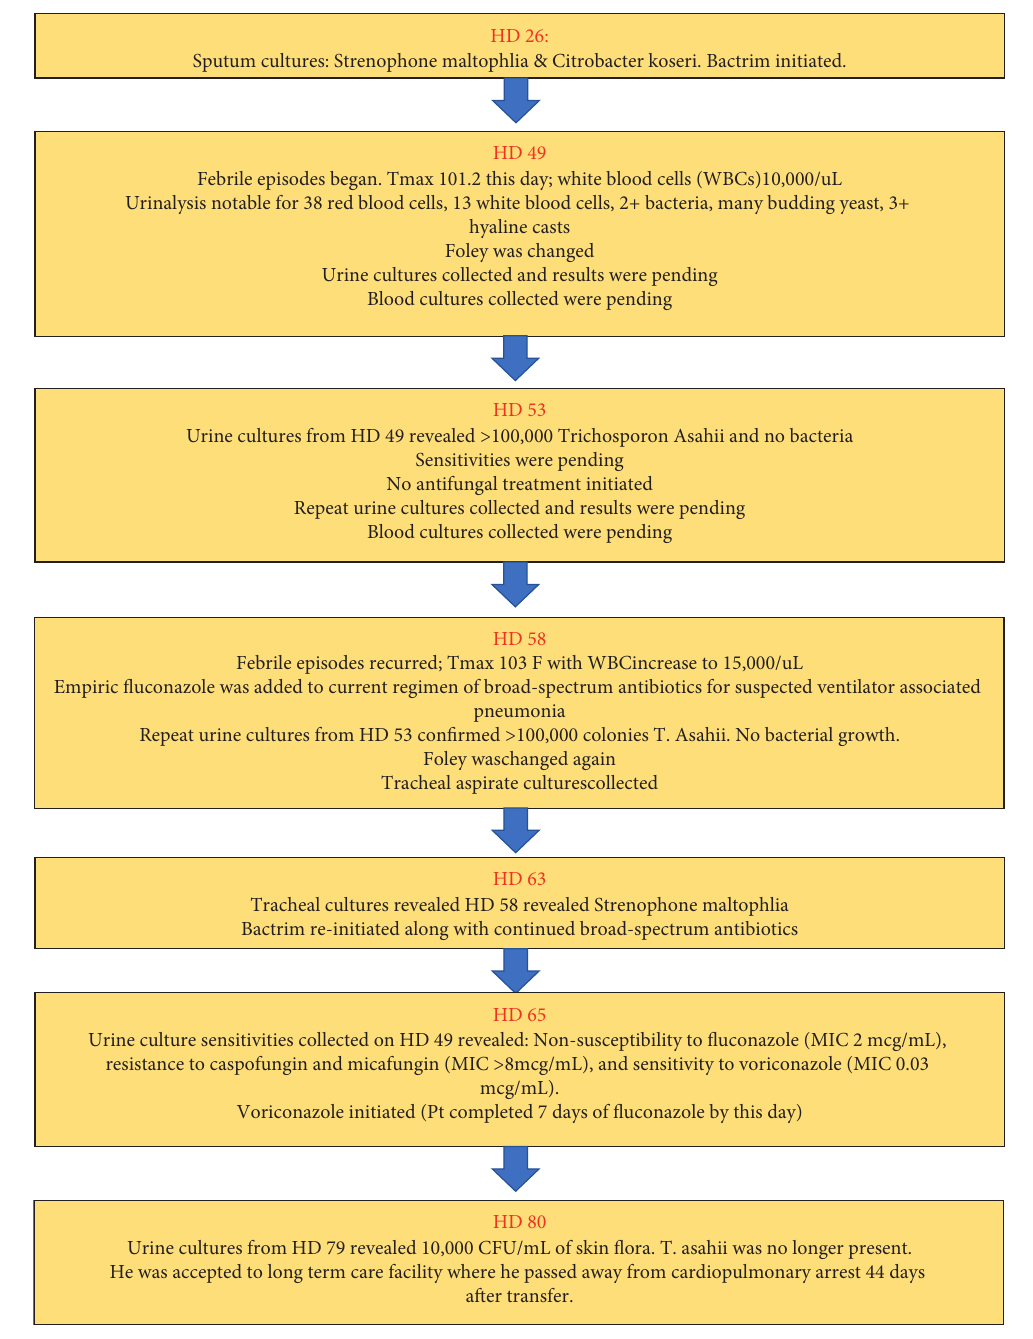
Figure 1: Flow chart outlining the timeline of events surrounding T. asahii infection, treatment, and